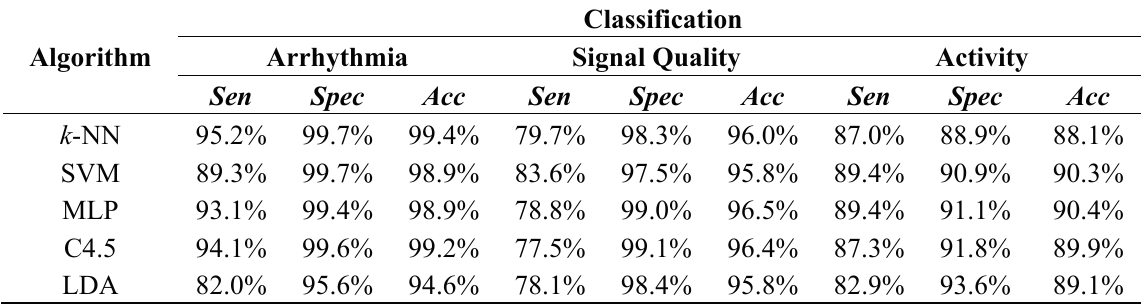
Table 7. Performance comparison of classification algorithms (using 5-fold cross validation on DS1 for arrhythmia classification and 5-fold cross validation on DS2 for signal quality and activity